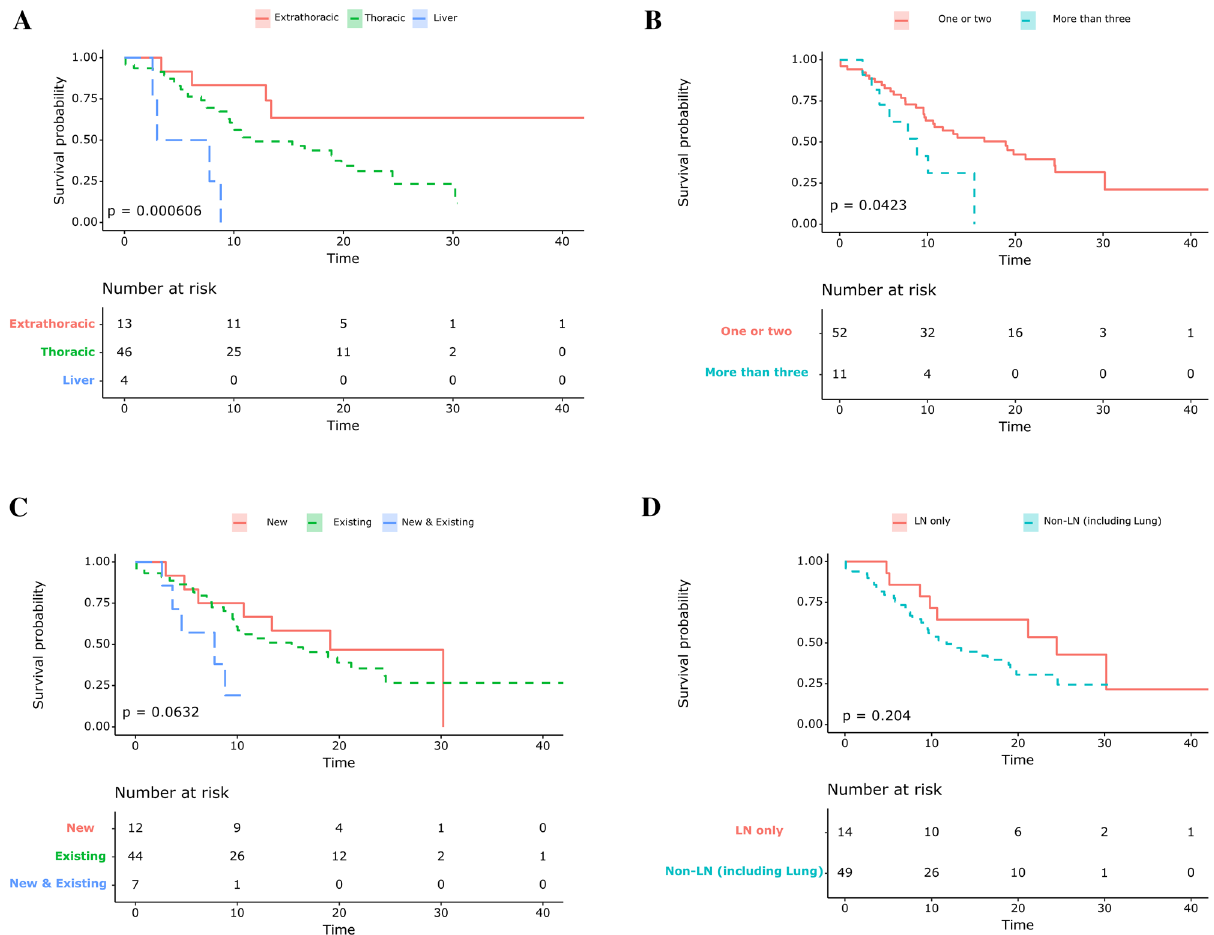
Figure 2. Kaplan–Meier survival curves showing overall survival from the point of acquired resistance for ( A ) the subgroup that had thoracic, extrathoracic, and liver progression only ( B ) the subgroup that had one or two progression sites or more than three progression sites ( C ) the subgroup that had progression from new lesions, existing lesions, and both new and existing lesions ( D ) the subgroup that had only lymph node and extranodal progression (including the